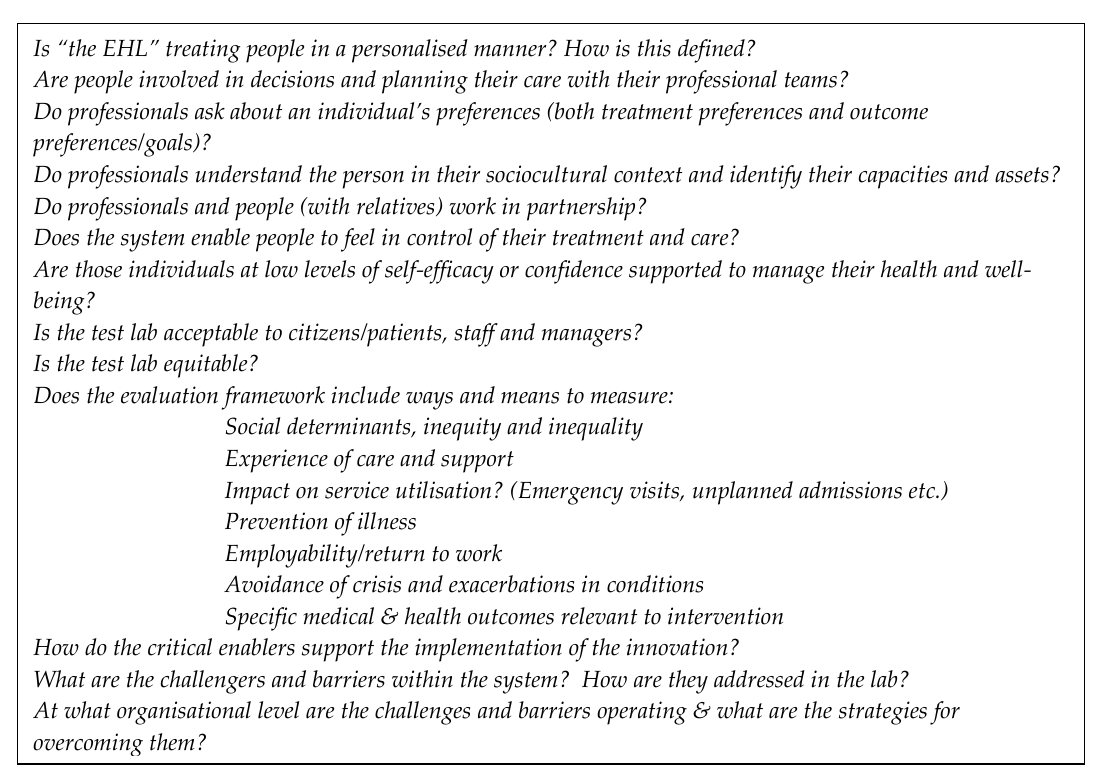
Figure 3. Questions for PCC practice and experience as a quality